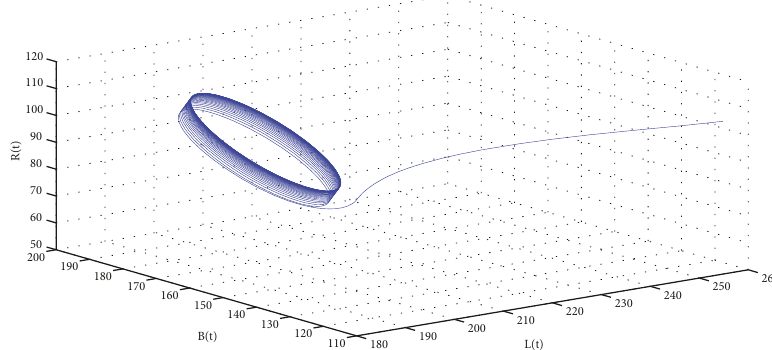
Figure 6: Dynamic behavior of system (61): projection on L-B-R with 𝜏 = 3.6755 > 𝜏 0 = 3.4685 .